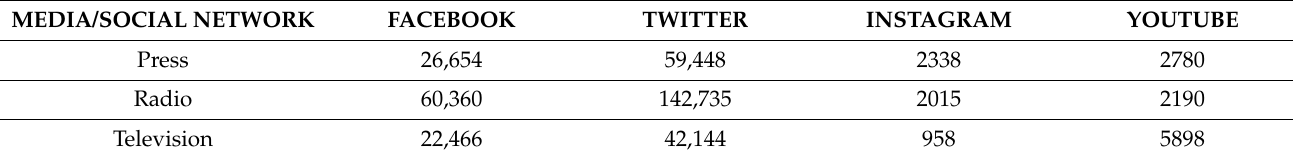
Table 2. Corpus of study downloaded from social